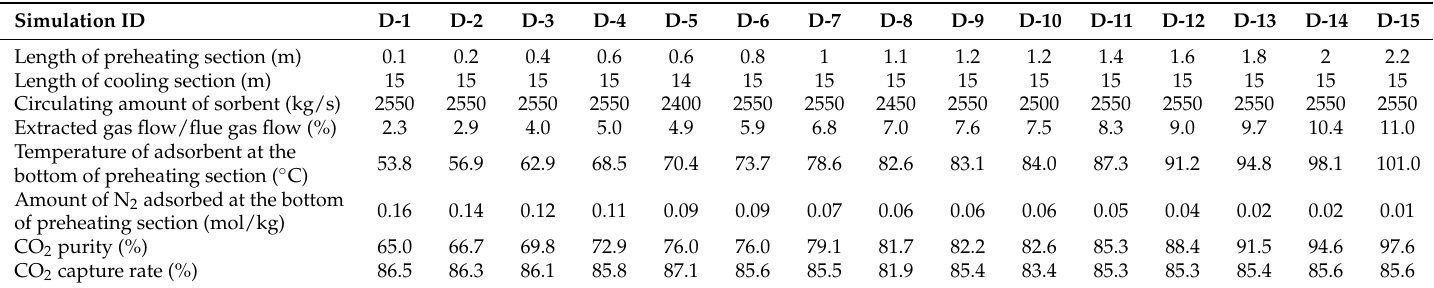
Table 7. Effect of length of preheating section on process performances for configuration